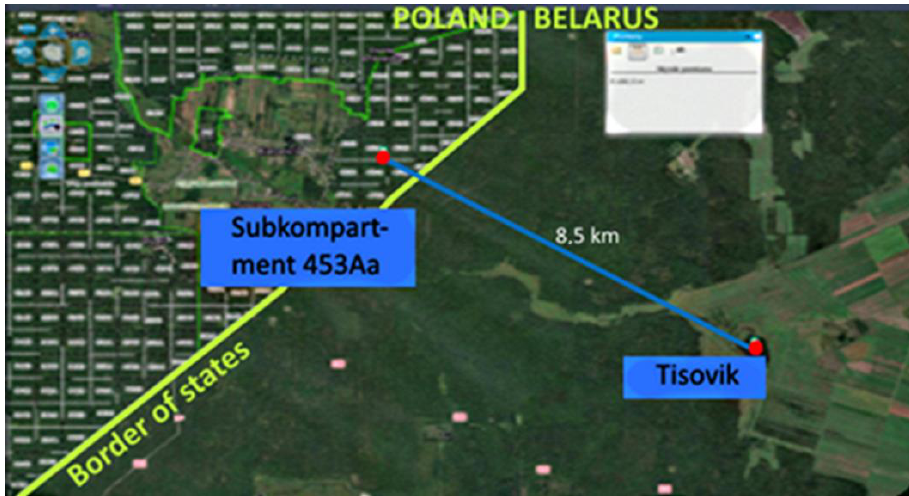
Figure 6. Localization of the silver fir refugium and the nearest fir stand in the Polish part of the Białowieża Forest (photo by W. Klimiuk).